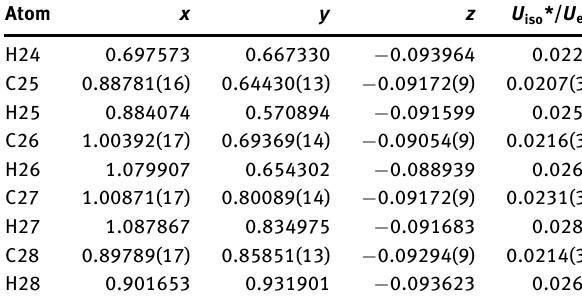
Table 2: Fractional atomic coordinates and isotropic or equivalent isotropic displacement parameters (Å 2